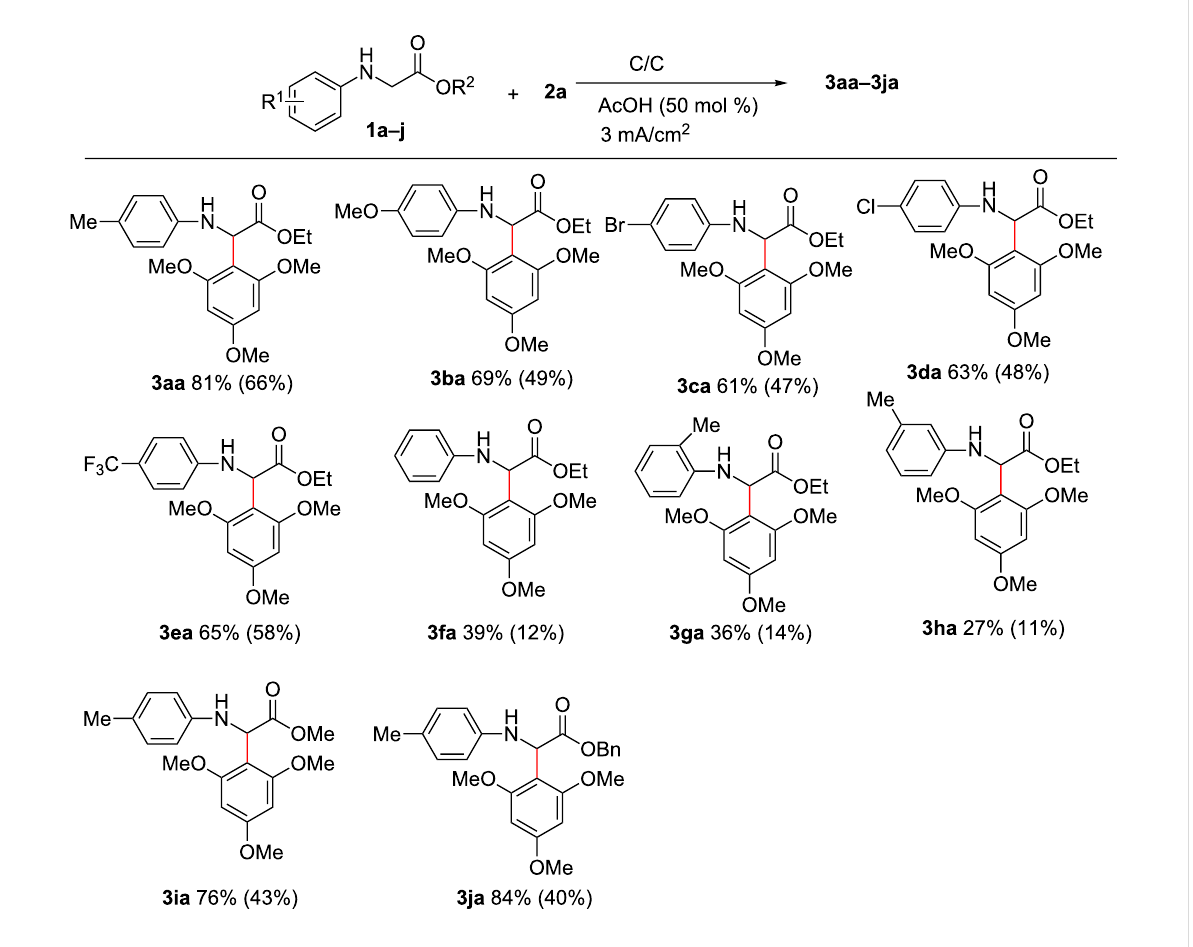
Scheme 2: Electrochemical CDC reaction of 2a and various N -arylglycine esters. Reaction conditions for the indirect electrolysis: 1 (0.5 mmol), 2a (0.6 mmol), n -Bu 4 NI (30 mol %), 0.1 M LiClO 4 /CH 3 CN (5 mL) and CH 2 Cl 2 (10 mL), AcOH (50 mol %), current density (3 mA/cm 2 ), graphite anode and cathode, at room temperature; reaction conditions for direct electrolysis: 1 (0.5 mmol), 2a (0.6 mmol), 0.1 M LiClO 4 /CH 3 CN (5 mL) and CH 2 Cl 2 (10 mL), AcOH (50 mol %), current density (3 mA/cm 2 ), graphite anode and cathode, at room temperature; yields in parenthesis obtained from direct